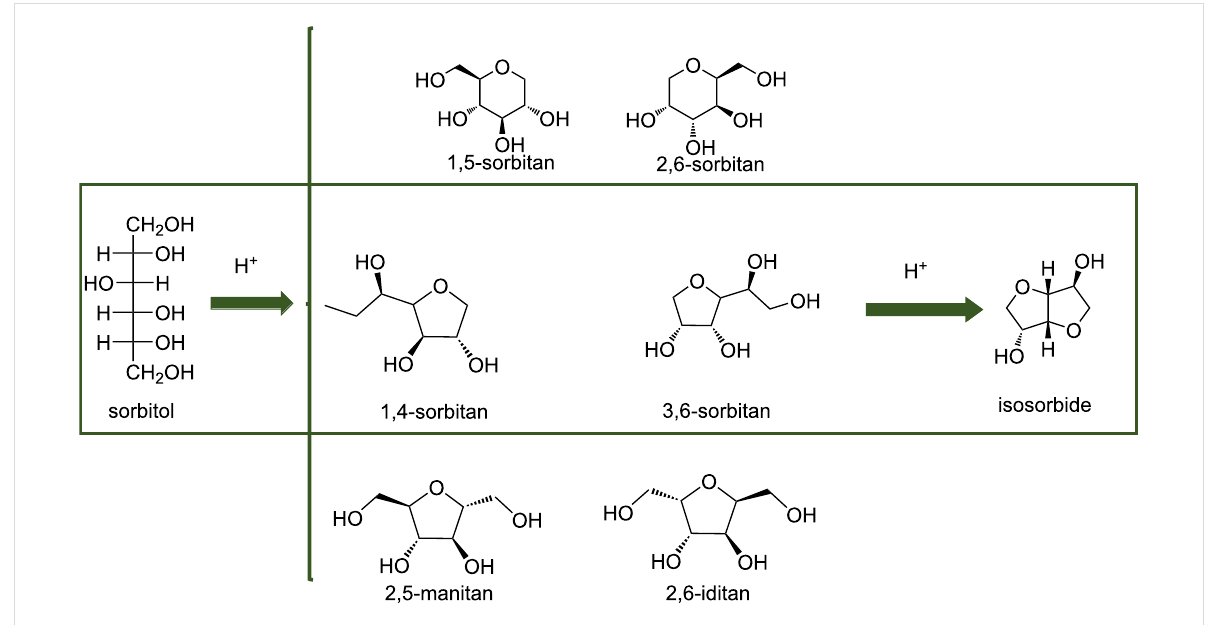
Scheme 3: Conversion of sorbitol to isosorbide via the formation of